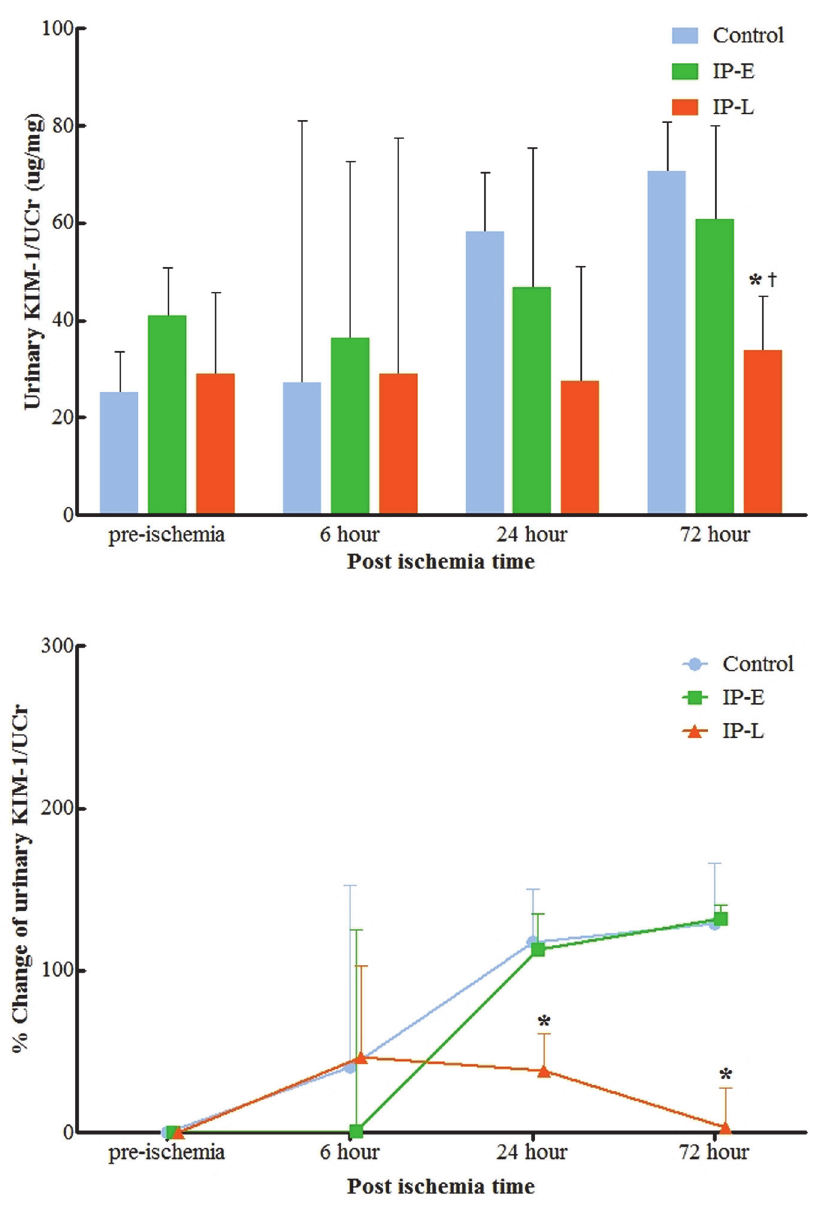
Fig 4. Changes in urinary KIM-1 (A) and urinary KIM-1 percent change from baseline (B) normalized to urinary creatinine. At 72 hours postoperatively, urinary KIM-1 was lower in the IP-L group than in the control and IP-E groups (p = 0.028 and 0.047, respectively). KIM-1, kidney injury molecule-1; Ucr, urine creatinine; IP-E, remote Ischemic preconditioning with early window; IP-L, remote ischemic preconditioning with late window. * p < 0.05 vs. Control, † p < 0.05 vs.